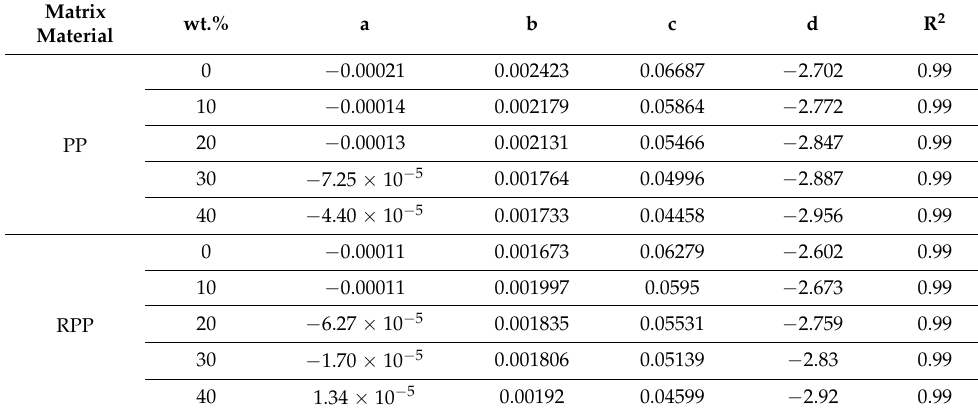
Table A1. Fitting factors and R 2 values.